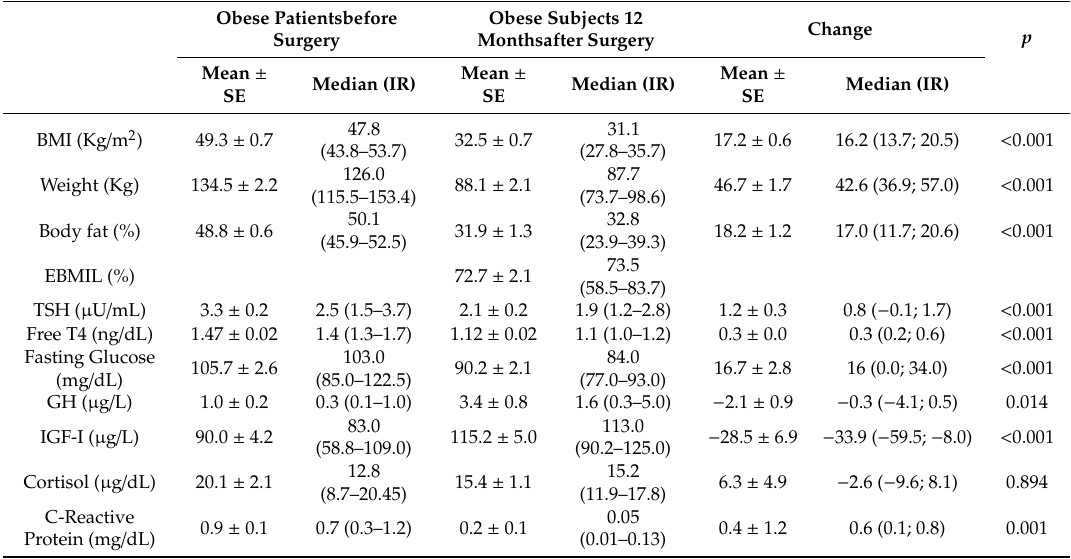
Table 3. Anthropometric, biochemical, and hormonal data in obese patients (mean ± SE; median, interquartile ranges).